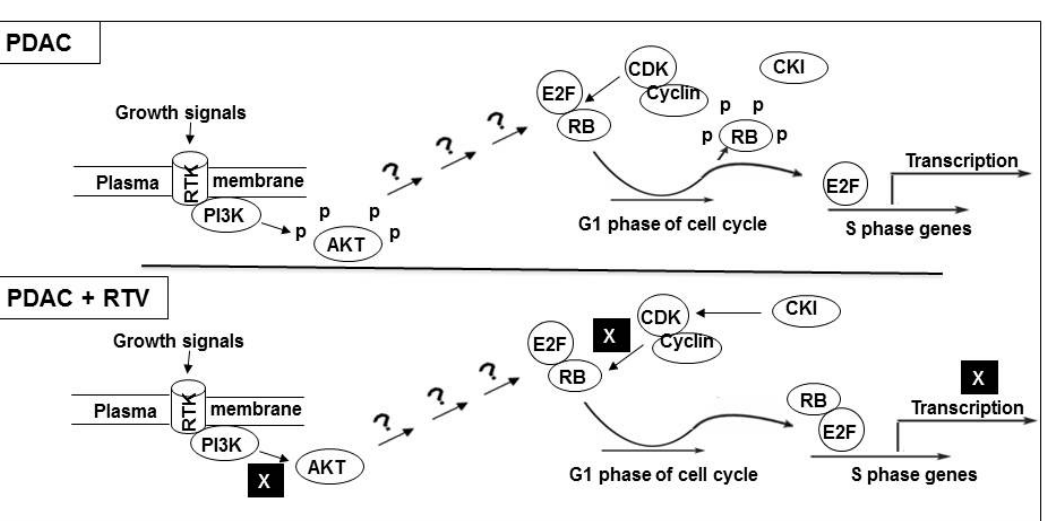
Figure 7. Schematic representation of signaling pathways from cell surface to nucleus modulated by ritonavir in PDAC: Upper panel : In the absence of ritonavir (RTV), growth signals from receptor tyrosine kinase (RTK) are conveyed to AKT via phosphotidyl inositol 3 kinase (PI3K). RB is inactivated by phosphorylation of cyclin-CDK complexes, resulting in the activation of E2F-1 transcription. E2F-1 target genes encode proteins involved in expression of S phase genes; Lower panel : In the presence of ritonavir, growth signals are inhibited by de-phosphorylation (activation) of RB, resulting in complex formation with E2F-1. This process inhibits transcription of S phase genes in two ways, passively via sequestration of E2F-1 and actively via the RB-E2F-1